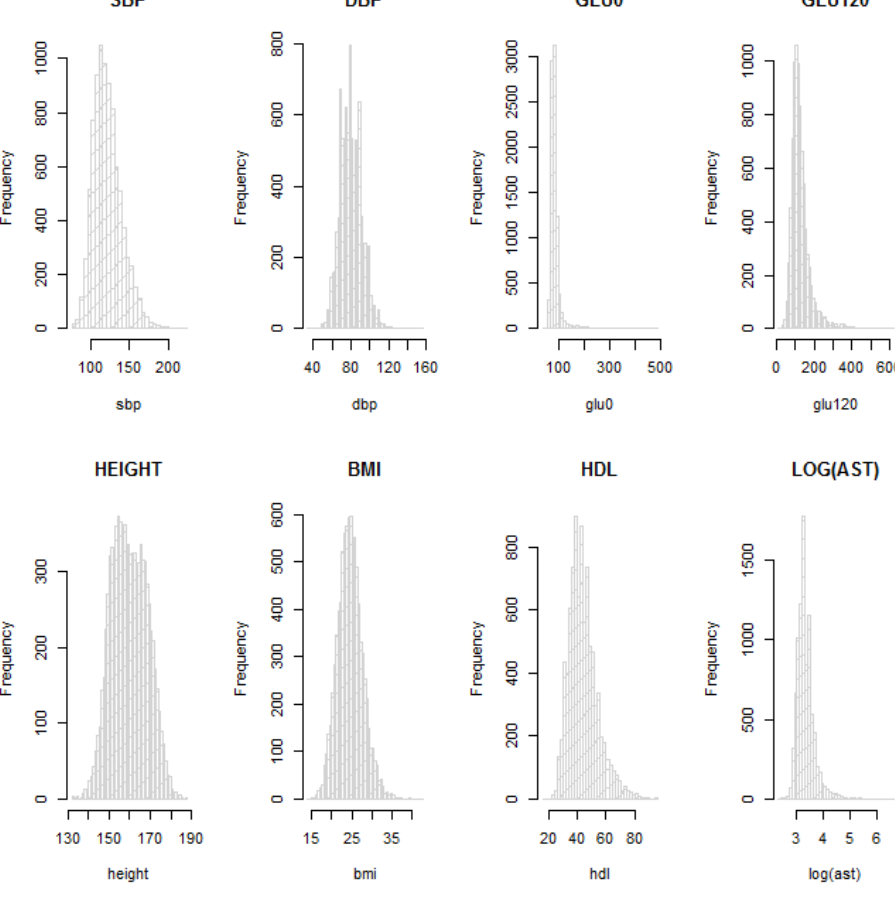
Table 3. Inflation factors by genomic